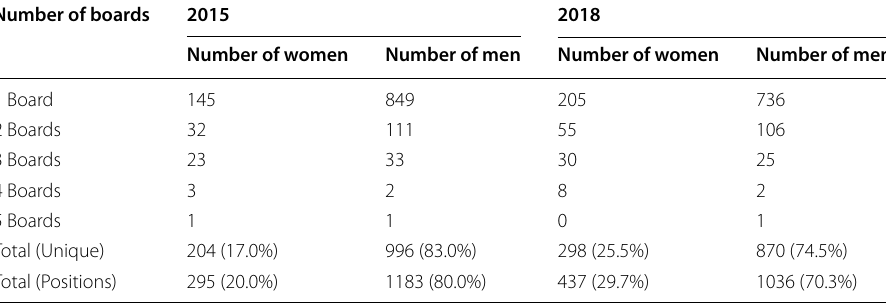
Table 1 Number of directors with one or more board seats (2015 and 2018)